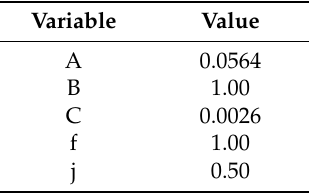
Table 5. Rounded parameters and parameter A adjusted by the least squares method.